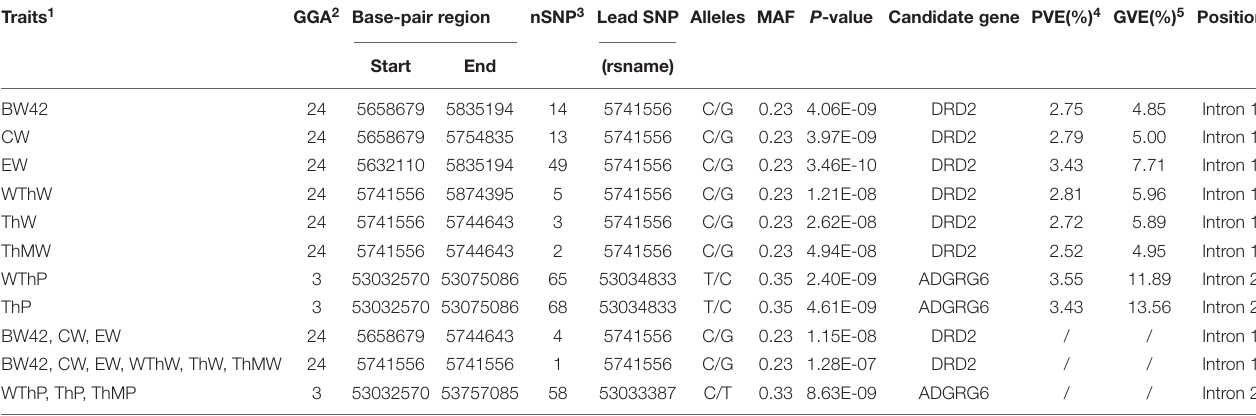
TABLE 2 | Overview of the significant QTLs of univariate GWAS and multivariate GWAS associated with target traits. Traits 1